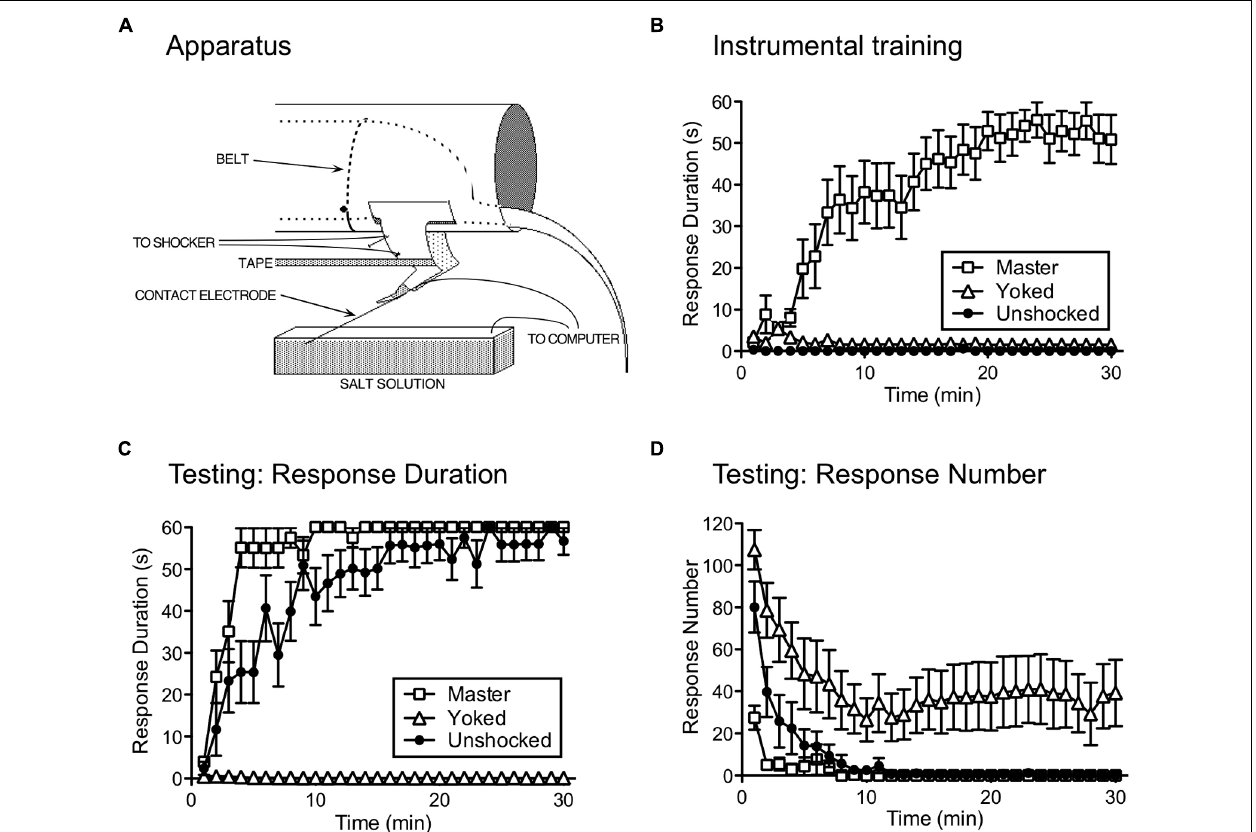
FIGURE 2 | Instrumental learning in spinally transected rats. (A) The apparatus used to study instrumental learning. A spinally transected rat lies in an opaque tube with its hindquarters gently secured with a belt. An insulated contact electrode is taped to the rat’s paw and the exposed tip is submerged in a salt solution. Electrical stimulation is applied to the tibialis anterior muscle through a pair of electrodes and tape is used to stabilize the leg. When shock is applied, a flexion response is elicited that raises the contact electrode, breaking a circuit that is monitored by a computer. A response–outcome (R–O) relation is instituted by applying shock whenever the contact electrode touches the underlying salt solution. The task can be made more difficult by increasing the initial depth of the contact electrode (from 4 to 8 mm). (B) A system capable of learning the R–O relation should exhibit an increase in flexion (response) duration that minimizes solution contact (and net shock exposure). Response duration (y-axis)